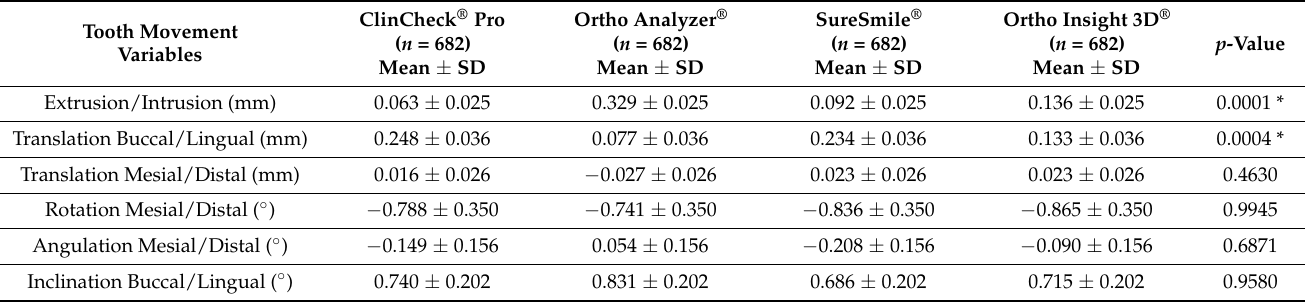
Table 1. Kruskal–Wallis one-way analysis of variance for all tooth